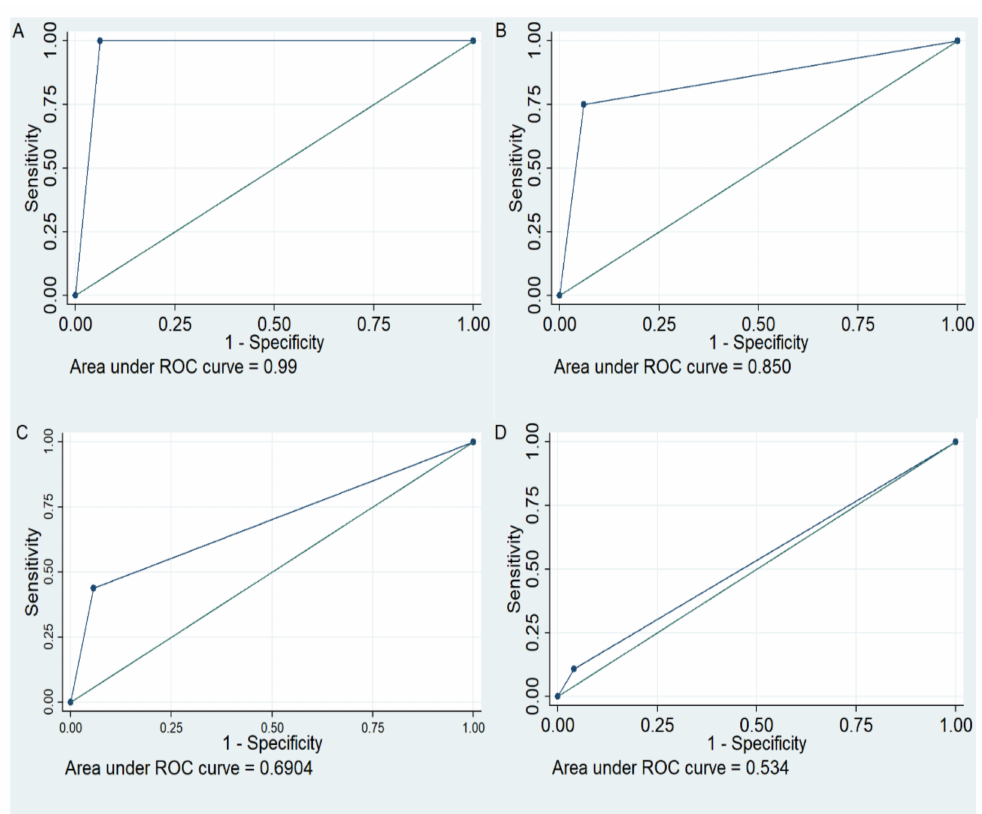
Figure 2. ROC curves showing performance of model 2 variants for predicting 5-Fluorouracil (5-FU) toxicity induced death, 5-FU induced haematological toxicities and global toxicity to 5-FU treatment. ( A ): Toxicity induced death, ( B ): Haematologi- cal toxicity grade 4 events, ( C ): Haematological toxicity grade 3 or 4 events, ( D ): Global